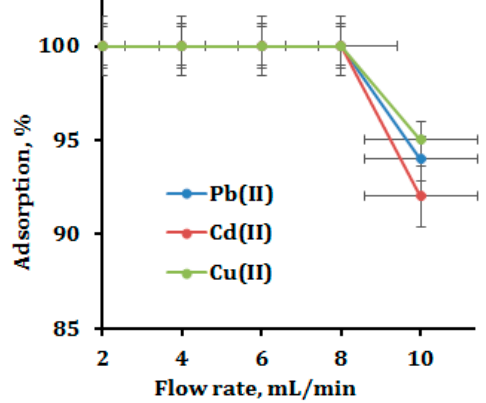
Figure 6. Effect of sample flow rate.